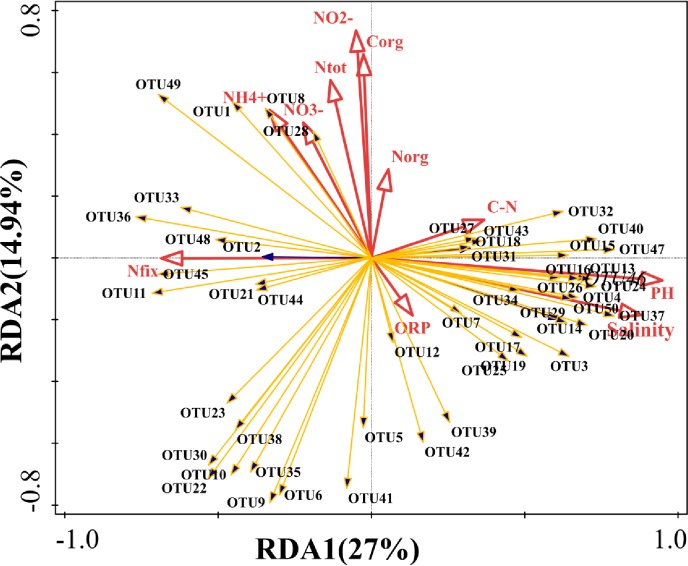
Redundancy analyses (RDA) of the communities and environmental parameters.Each yellow arrow represents an individual OTU and the red arrows represent statistically significant environment variables that explain the corelation patterns (P < 0.05).